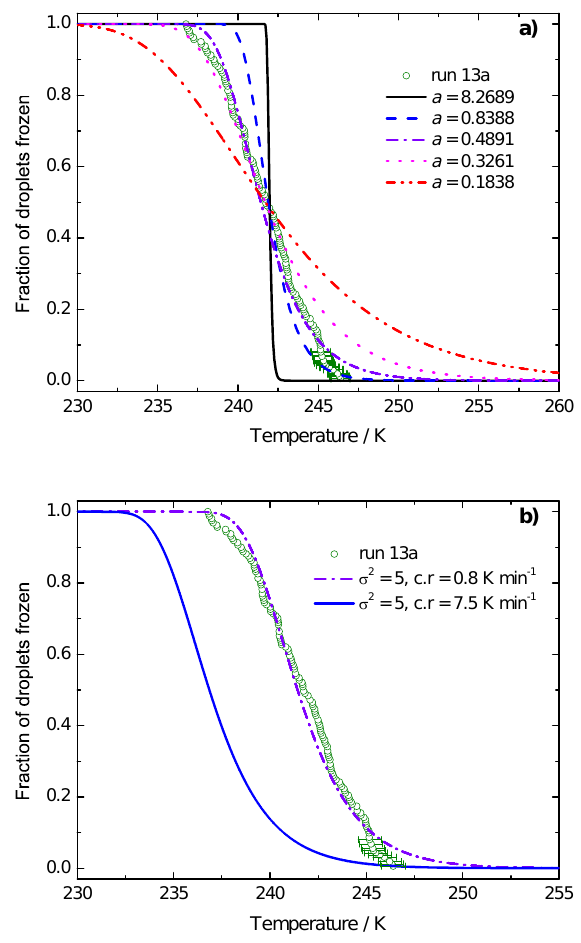
Fig. 9. Theoretical f ice (T ) curves for droplets containing inter- nally mixed nucleation sites of varying ice-nucleating ability, which were characterised by ln( J i (T )) = - aT + b i . Also shown is run 13a, for comparison (limited T uncertainties are shown, for clarity). (a) Theoretical curves are shown for different values of a , where σ b was kept constant (see text). µ b was varied to best fit the experi- mental f ice (T ) curve. The following values of µ b were used: µ b = 2000, 200, 114.7, 75 and 40 for a =8.2689, 0.8388, 0.4891, 0.3261 and 0.1838, respectively ( σ 2 = 5). All theoretical f ice (T ) curves b were calculated for a cooling rate of 0.8Kmin − 1 . (b) The affect of changing the cooling rate is shown using curves calculated with a value of a = 0.4891. This shows that the internally mixed model is inconsistent with the experimentally observed lack of cooling rate